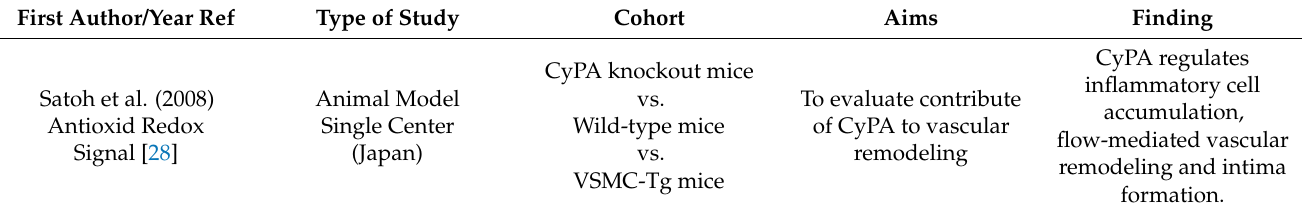
Table 2. Characteristics of the Included